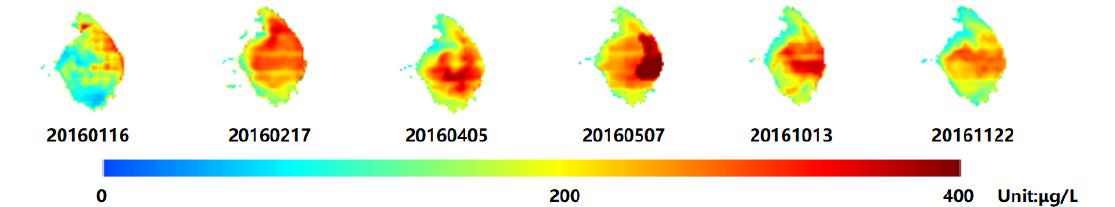
Figure 6. TP concentration distribution of Lake Okeechobee in